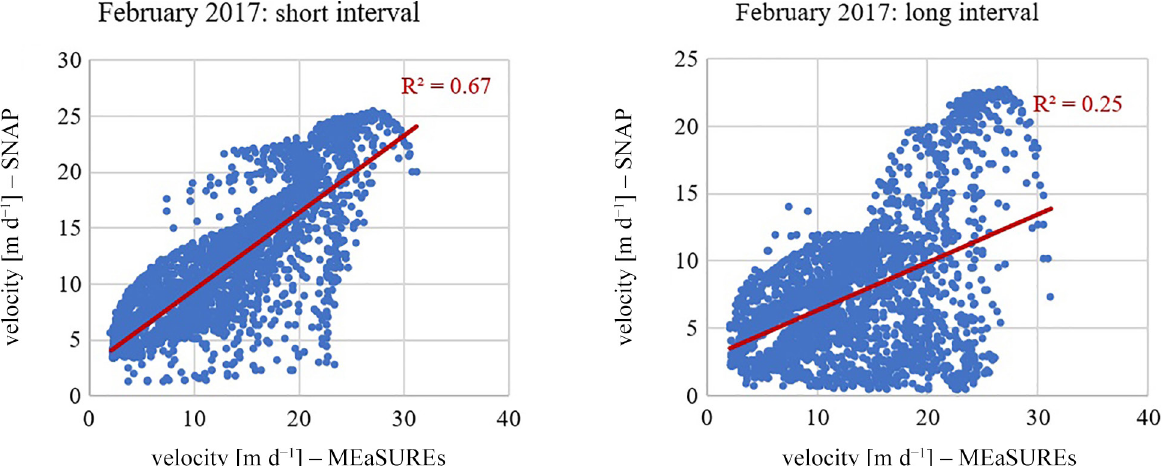
Fig. 5. correlation plots for winter